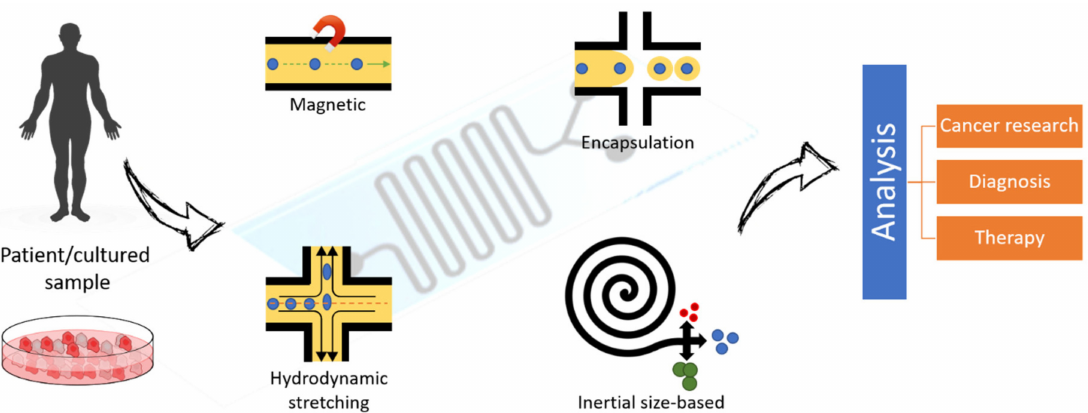
Figure 6. Schematic representation of the most commonly used techniques for the isolation, trapping and manipulation of single cells in a microfluidic device. Potential scope of applications is